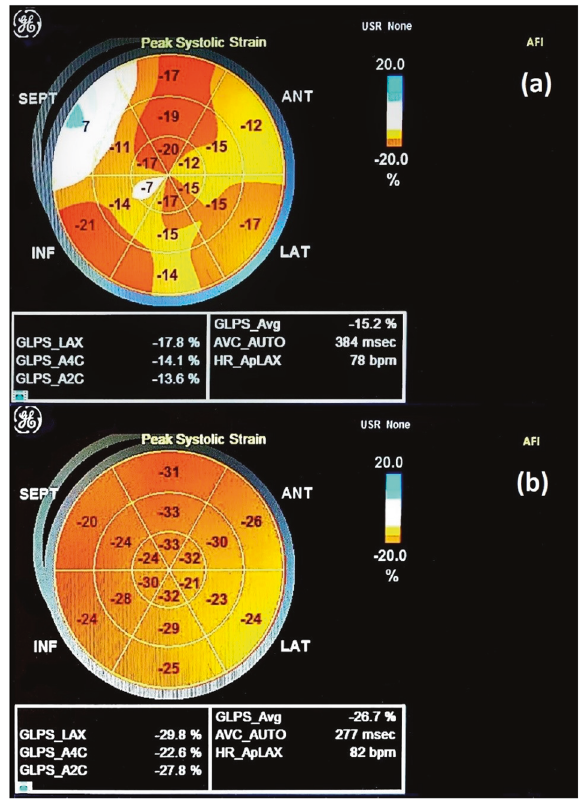
Fig. 2 Peak systolic strain and global longitudinal strain assess- ment using speckle tracking echocardiography. a Abnormal values and b normal